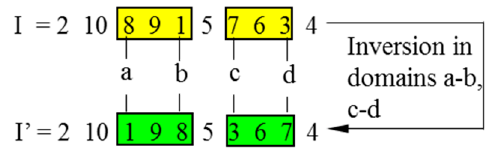
Figure 5. Double-domain inversion.